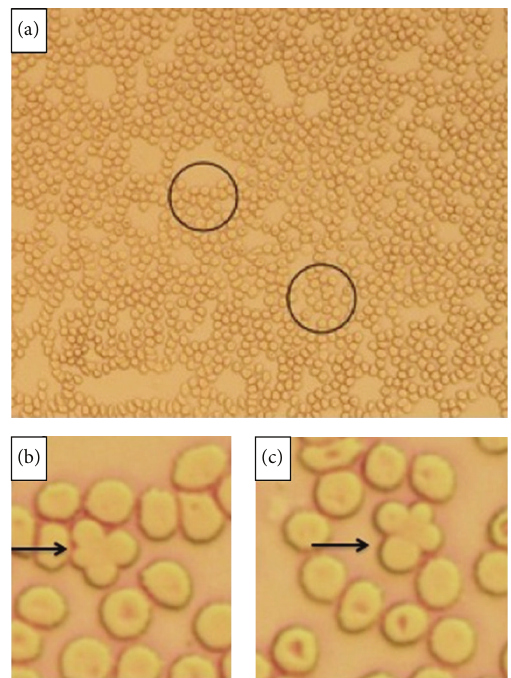
Figure 5: Unstained blood film in the feathered edge area where it can be seen two qRBCs at low (20x, black circle) (a) and high magnification (100x, black arrow) (b) and (c). These samples were used for SEM investigation.